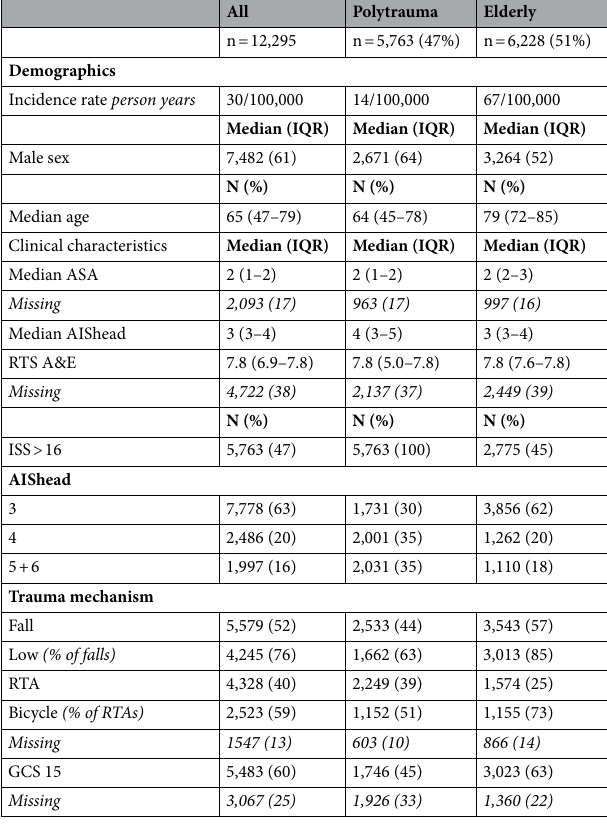
Table 1. Baseline variables. IQR = Interquartile range, ASA = American Society of Anaesthesiologists score, AIShead = Abbreviated Injury Scale of the head region, ISS = Injury Severity Score, RTA = Road traffic accident, GCS = Glasgow Coma Scale score, RTS = Revised Trauma